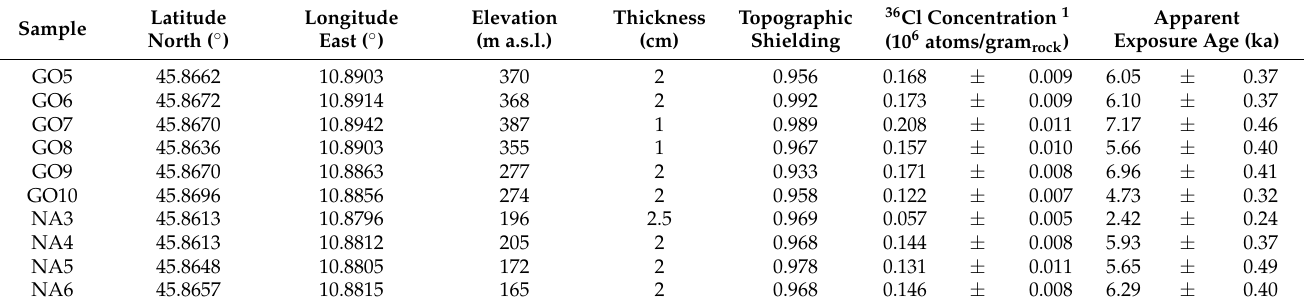
Table 1. Sample name, AMS-measured 36 Cl concentrations and calculated apparent exposure ages (Figure 5). Latitude Sample North ( ◦